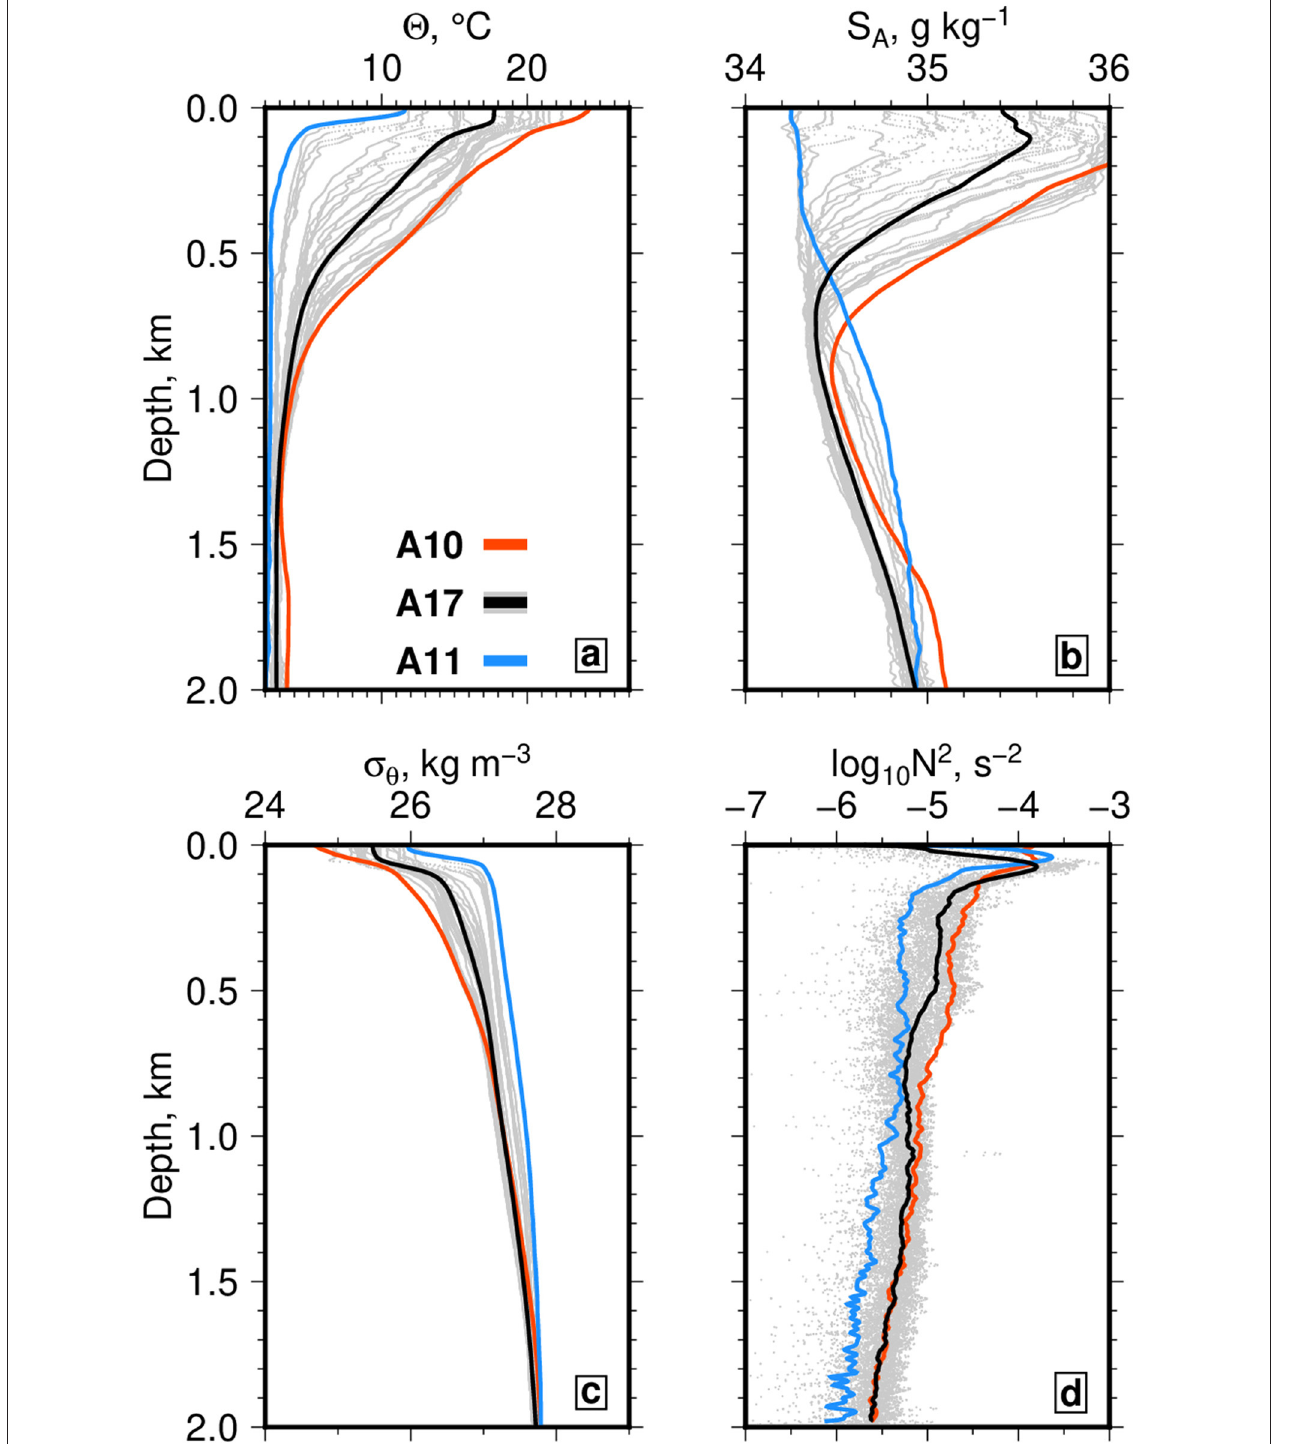
FIGURE 2 | Hydrographic profiles calculated from CTD casts acquired along GO-SHIP sections A10, A11, and A17 that are representative of subtropical, subantarctic and intermediate water masses, respectively (see Figure 1A for location). (A) Conservative temperature, 2 , plotted as function of depth. (B) Absolute salinity, S A , plotted as function of depth. (C) Potential density anomaly, σ θ , plotted as function of depth. (D) Buoyancy (Brunt-Väisälä) frequency squared, N 2 , plotted on logarithmic scale as function of depth. In each panel, gray lines = individual profiles of A17 casts; red line = average profile calculated from 8 CTD casts along A10; blue line = average profile calculated from 8 CTD casts along A11; black line = average profile calculated from 14 CTD casts acquired along A17 (see enlarged white circles in Figure 1A ). All profiles smoothed using 100 m low-pass Butterworth filter.